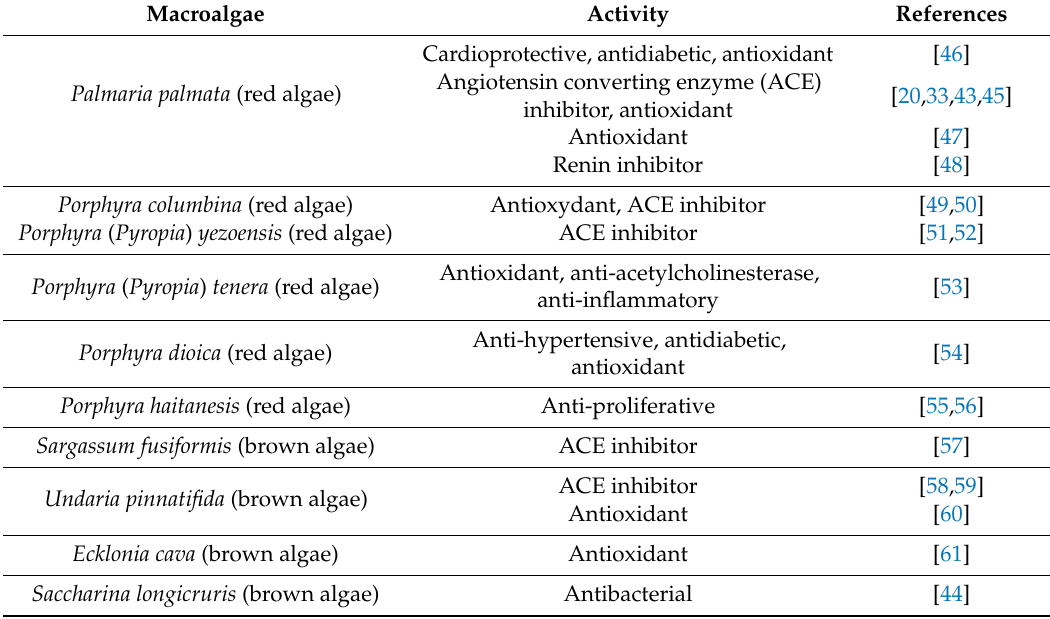
Table 1. Bioactivity of peptides derived from marine macroalgae protein